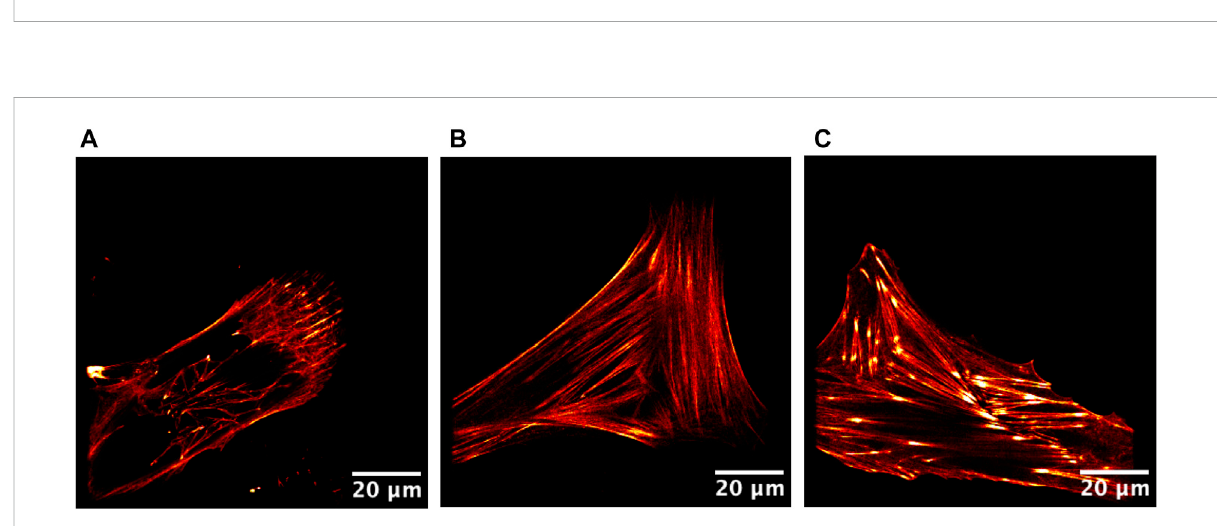
FIGURE 5 STED images of live single cells plated on cell culture dishes. (A) Control fi broblasts, (B) scar fi broblasts, and (C) Dupuytren fi broblasts. Actin fi bers were labeled in red. Scale bar: 20